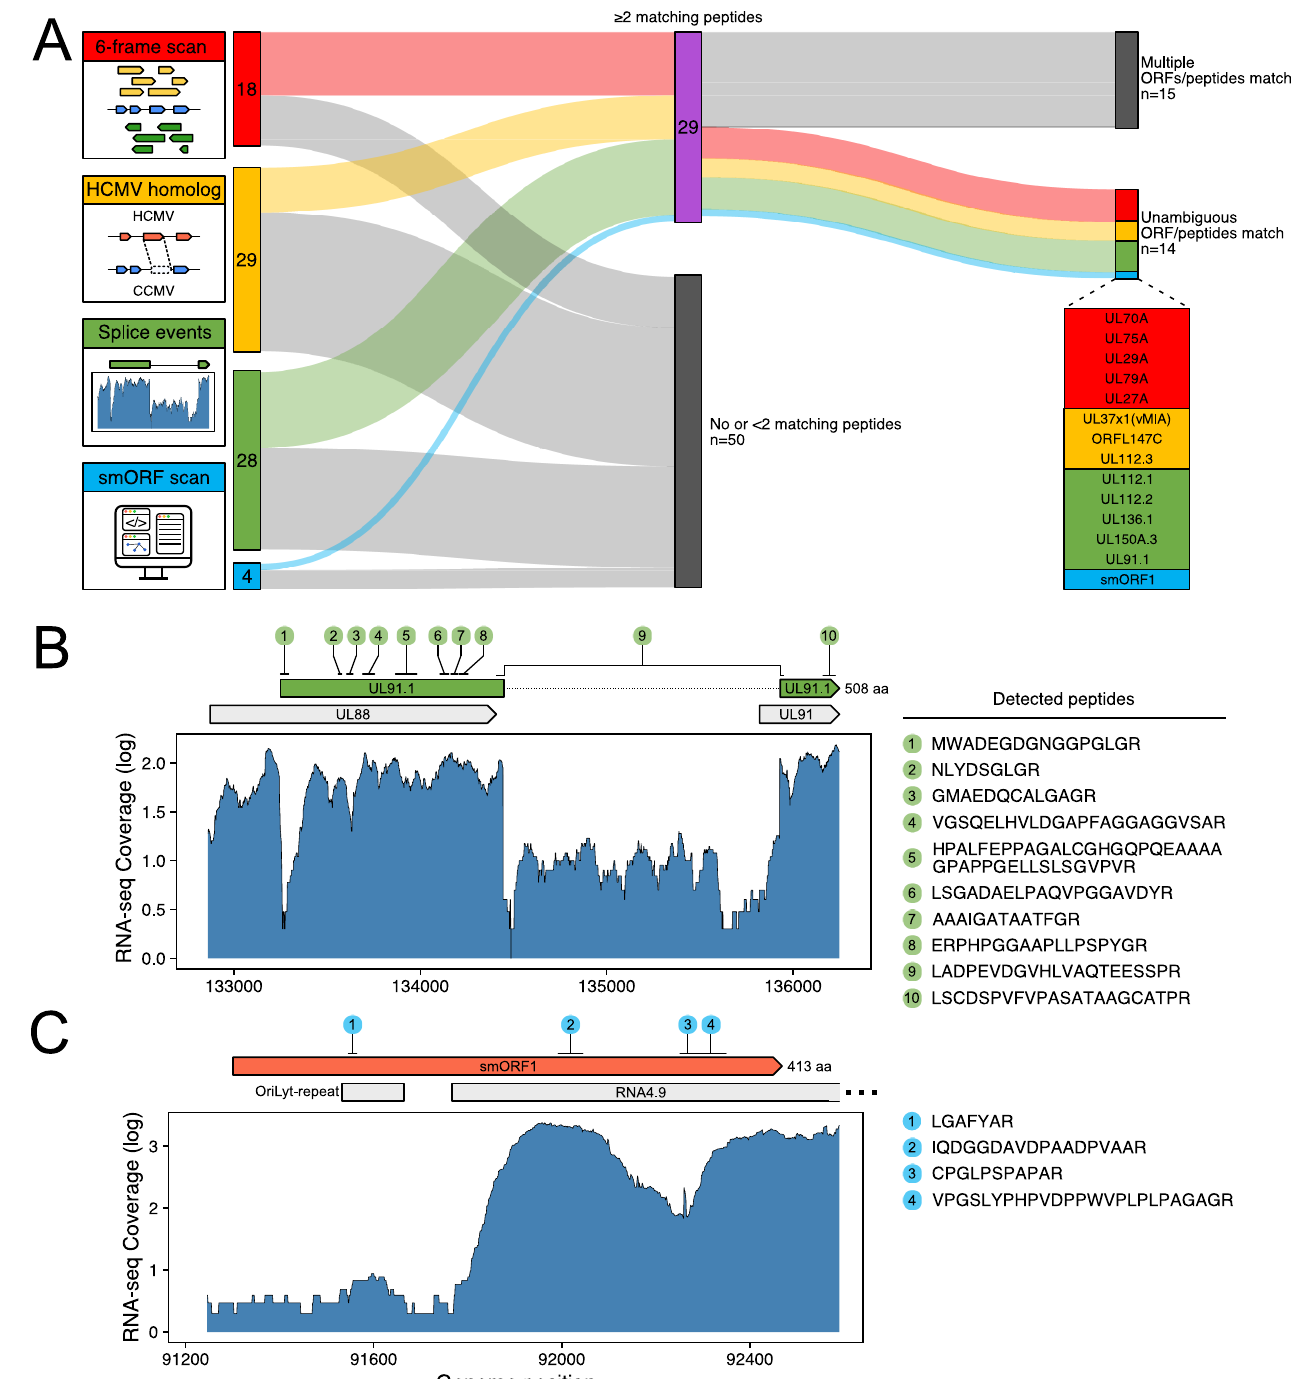
Fig 5. Re-evaluation of the CCMV coding potential. (A) To annotate potential novel coding sequences, the CCMV genome was scanned for unknown six- frame translation products, for homologs of non-canonical HCMV ORFs [6], for splice variants and for small ORFs (smORFs). To validate the candidate ORFs (numbers are indicated), proteomic data of CCMV-infected cells was analyzed for matching peptides. In total, 14 novel gene products were unambiguously identified by at least two unique peptides. (B) UL91.1 as an example of a newly found non-canonical CCMV ORF. RNA sequencing (RNA-seq) of infected cells detected a splicing event between the UL88 and UL91 locus. Multiple peptides matched the annotated ORF sequence, including the N-terminal peptide and a peptide spanning over the exon/exon junction, thus confirming translation of this splice variant. (C) smORF1 is another unique ORF with yet unknown function that overlaps the lytic replication origin of CCMV including the 5’-end of the long non-coding RNA4.9.